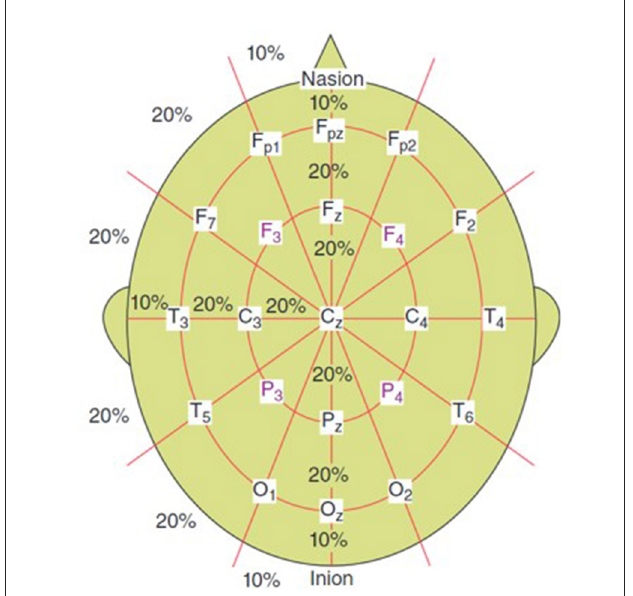
FIGURE1 10–20 electrode setup for EEG (Sanei and Chambers,